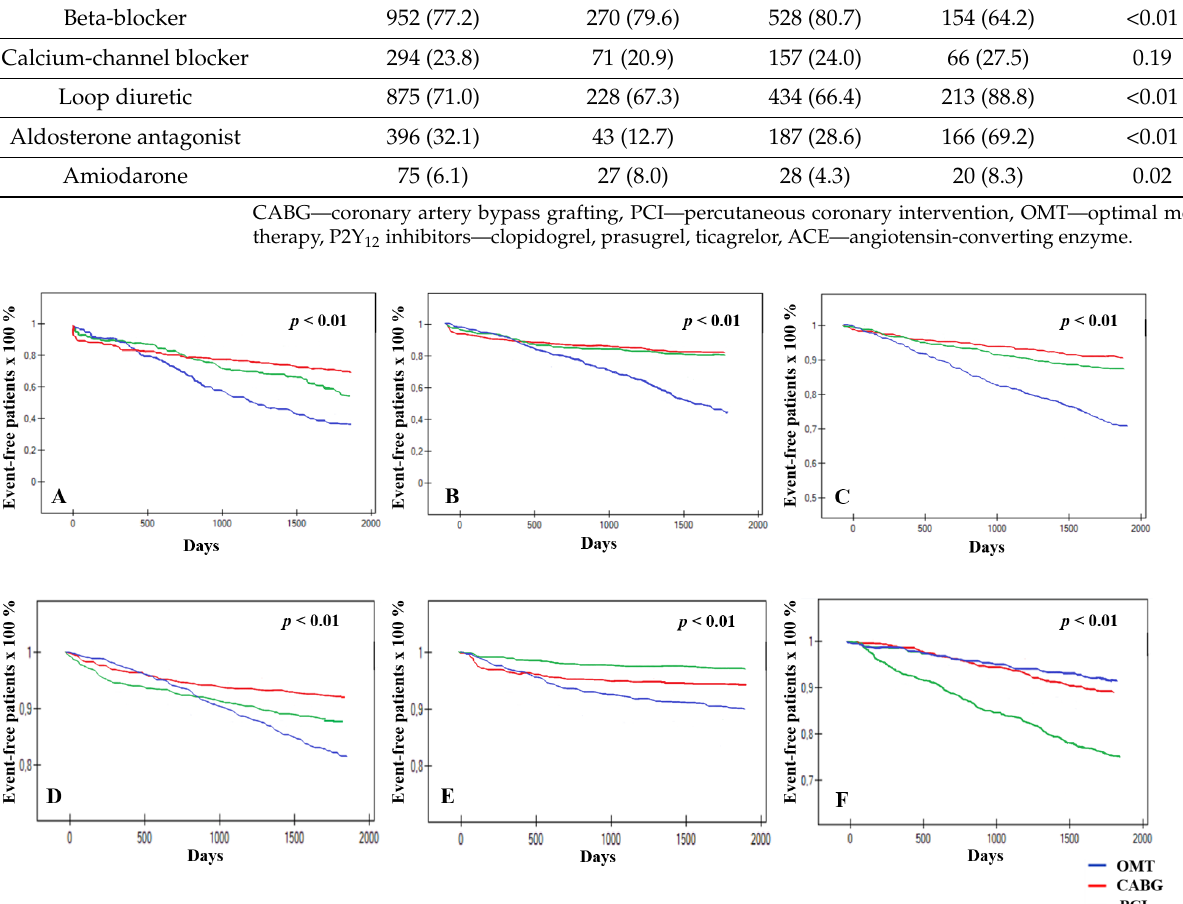
Table 3. Primary and secondary endpoints.